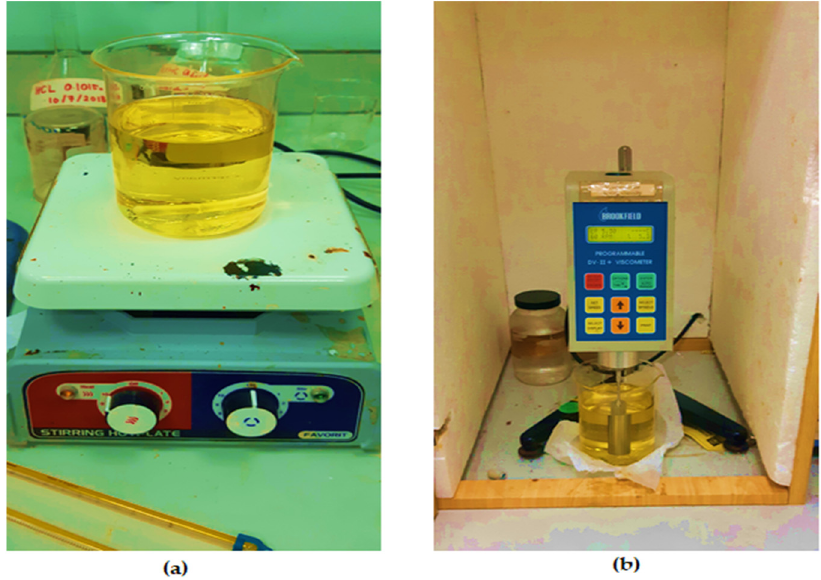
Figure 3. ( a ) Hot plate; ( b ) Viscometer for viscosity measurement.